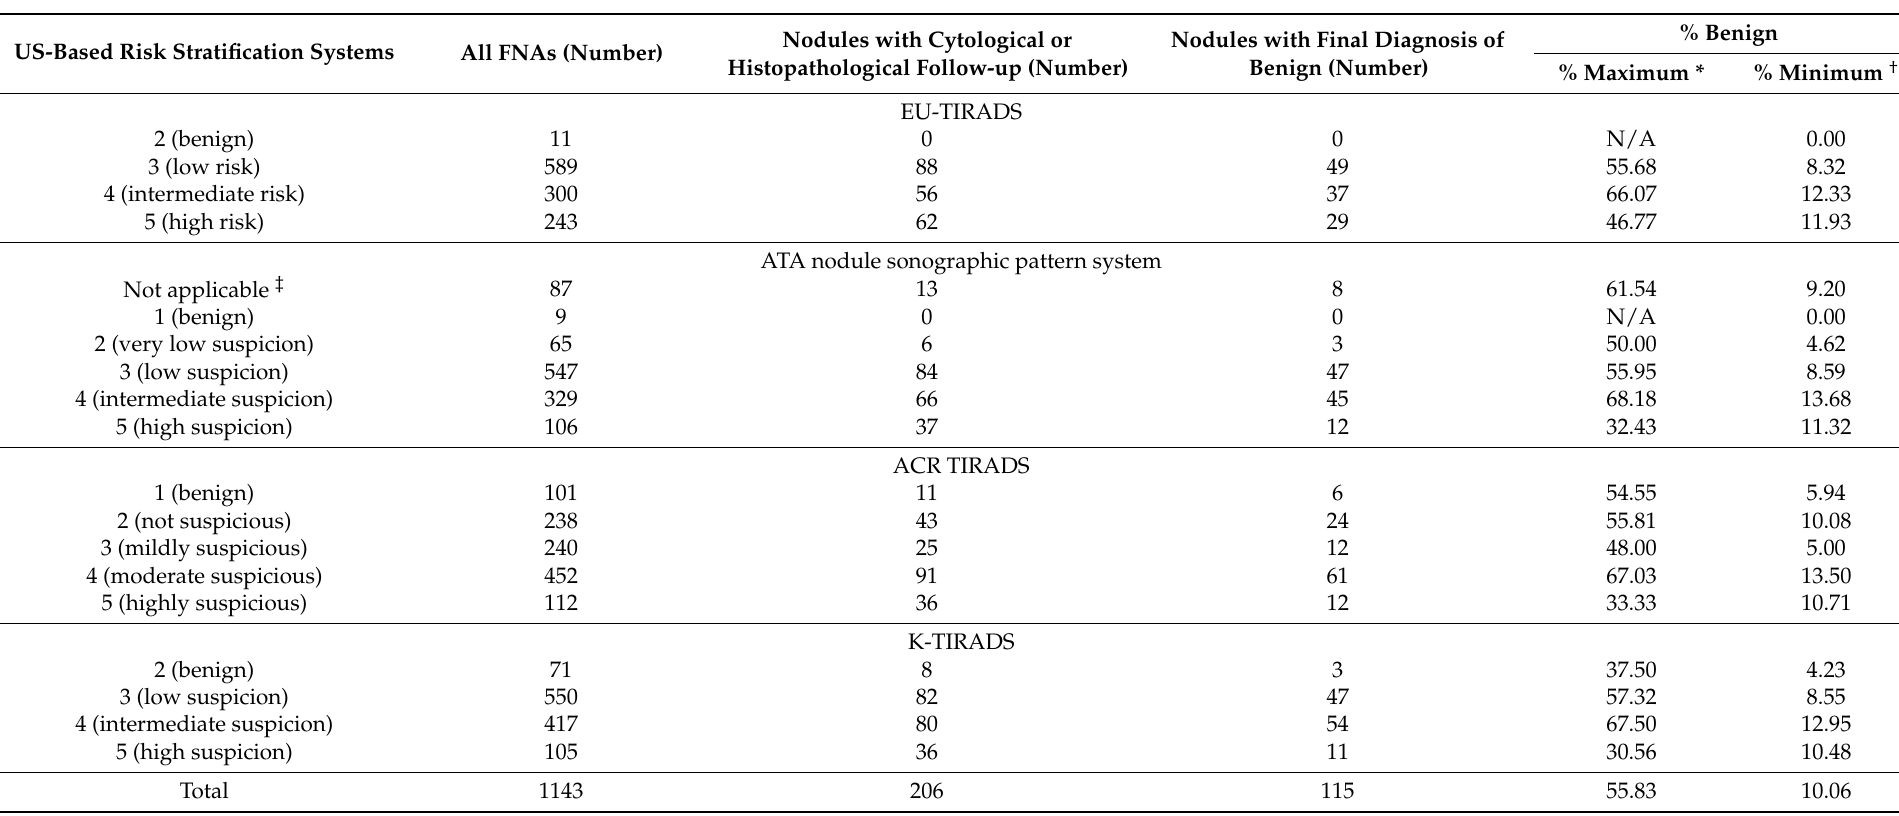
Table 3. Benign rates of thyroid nodules with nondiagnostic or unsatisfactory cytopathological results according to categories of ultrasonography-based risk stratification systems. US-Based Risk Stratification